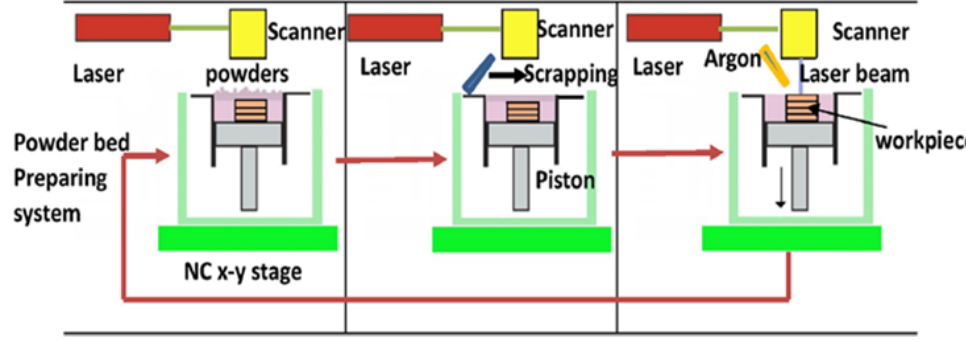
Figure 16: Schematic diagram of the laser 3D printing graphene aluminum process. Reproduced from Reference [133].